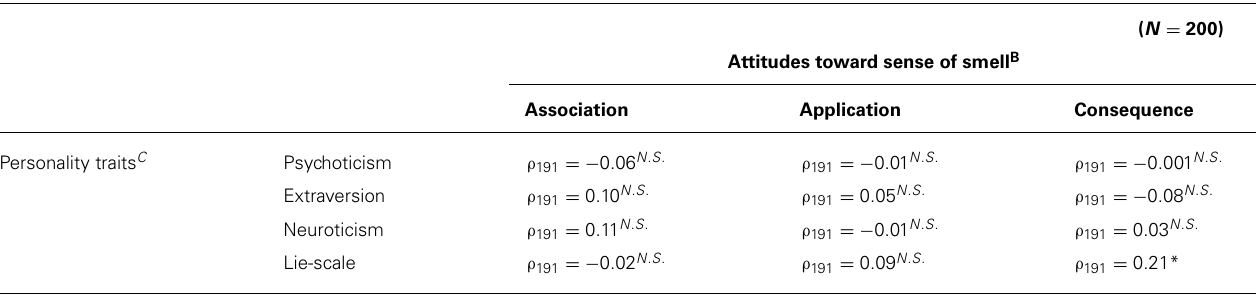
Table 3 | Partial Spearman correlation coefficients for the relationships between personality traits and attitudes toward sense of smell A